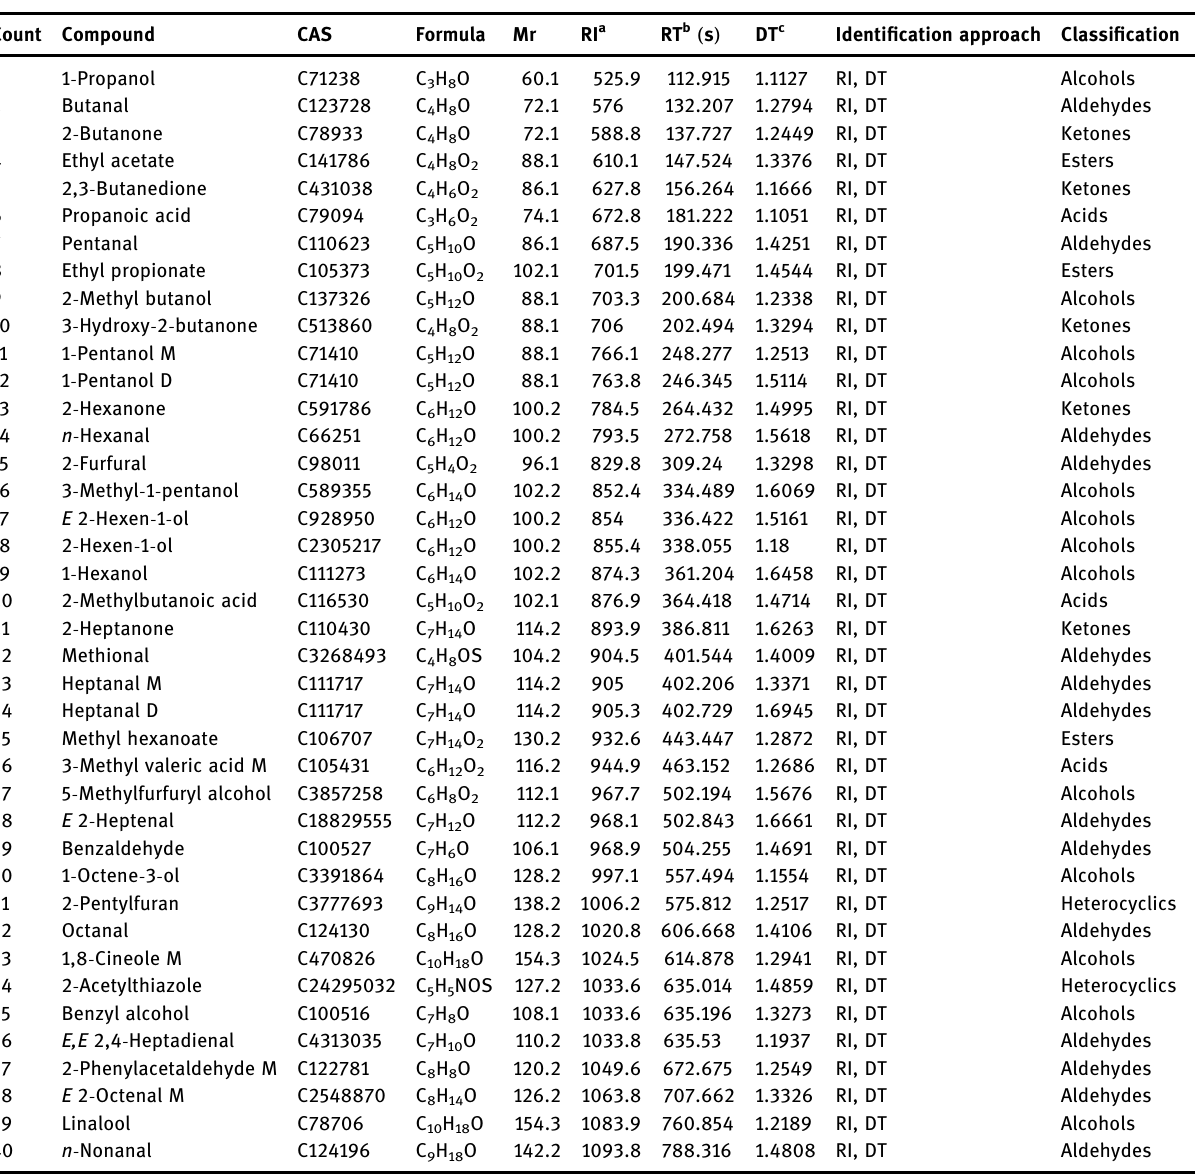
Table 1: GC - IMS integration parameters of